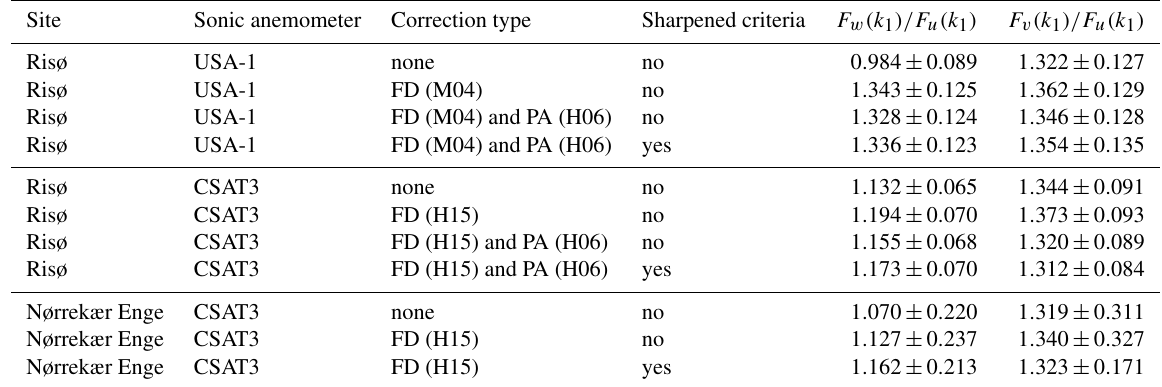
Figure 4. Velocity spectra ratios by the USA-1 at the Risø test site as function of wind direction. (a) w to u velocity and (b) v to u velocity spectra ratios for the non- and 3-D-corrected data. Each 10min ratio is shown in markers and the solid lines show a loess fit of the scatter. The thick dashed vertical line indicates the 0 ◦ direction, the thin dashed vertical lines indicate the sector with possible turbine wakes, and two dashed horizontal lines the values 1 and 4 / 3. The standard error of the fit to the 3-D-corrected w to u velocity spectra ratios is within 0.0020–0.0031. Table 2. Computed velocity spectra ratios within the inertial subrange for the direction range within ± 120 ◦ and excluding directions possibly affected by turbine wakes. The mean value is given ± 1 standard